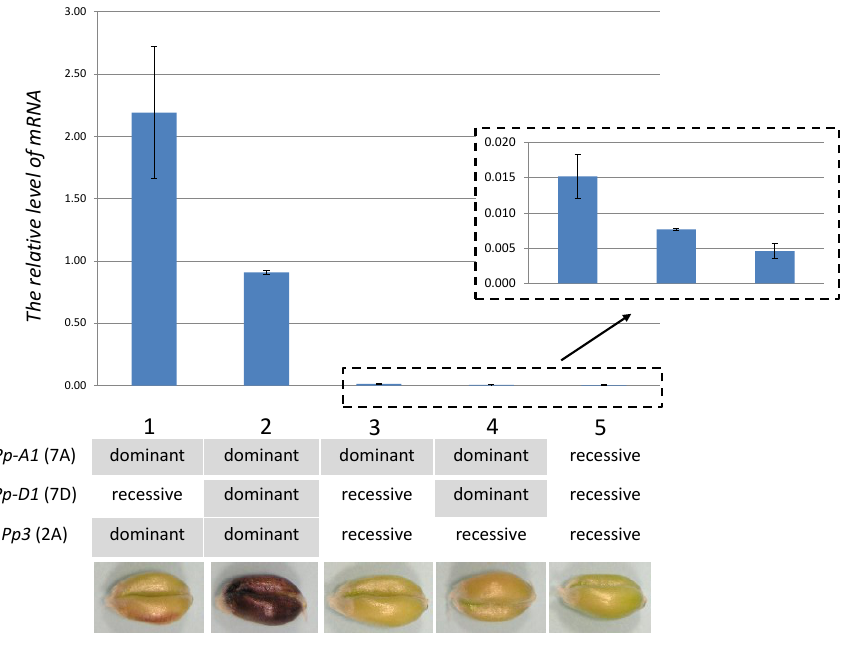
Supplementary Table S5. The phenotypes of lines set generated on “Purple” as a donor of Pp genes are